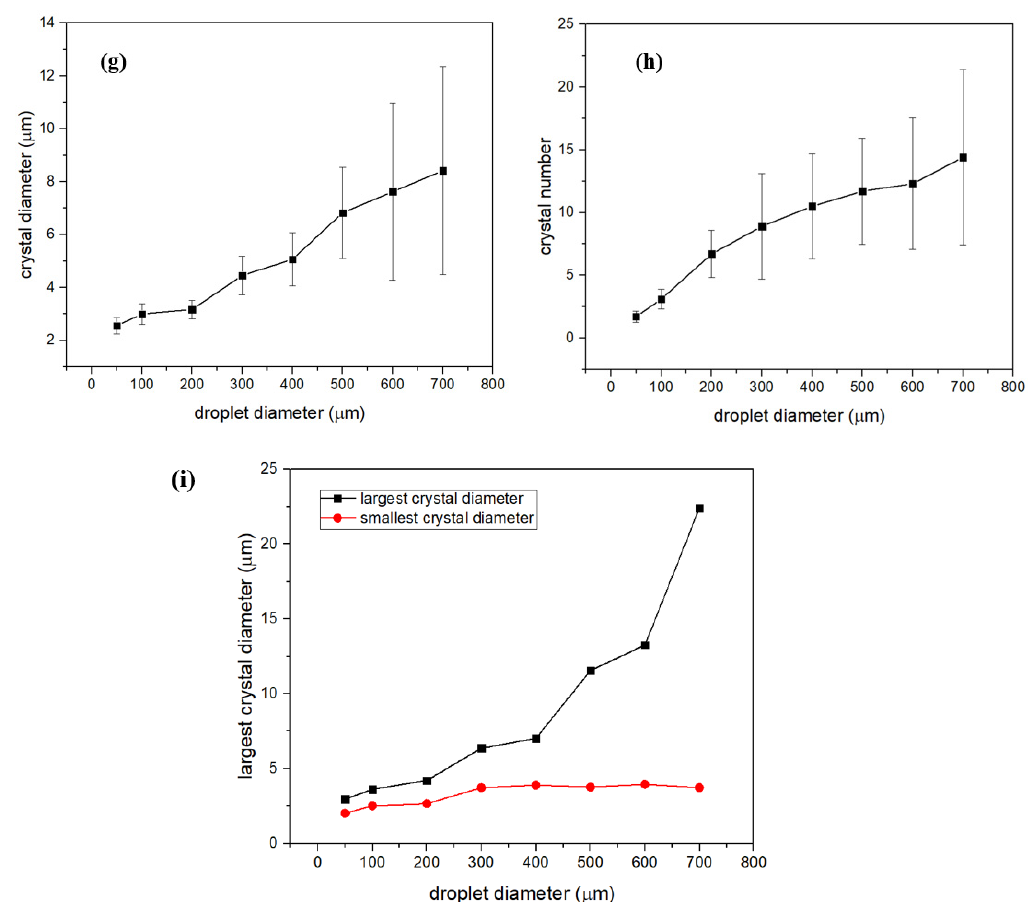
Figure 3. Optical micrograph of CaCO 3 formed in microdroplets at different diameters and statistical data graph: ( a ) 50 µ m, ( b ) 100 µ m, ( c ) 400 µ m. ( d ), ( e ), ( f ) crystals formed in the droplet with 300 µ m, 400 µ m, 700 µ m respectively. ( g ) The relation between average diameter of crystals and droplet diameter. ( h ) The relation between average amount of crystals and droplet diameter. ( i ) The relation largest & smallest crystal diameter of crystals and droplet diameter. Scale bars in ( a ), ( b ), ( d ), ( e ), ( f ) is 10 µ m, Scale bars in ( c ) is 100µm.